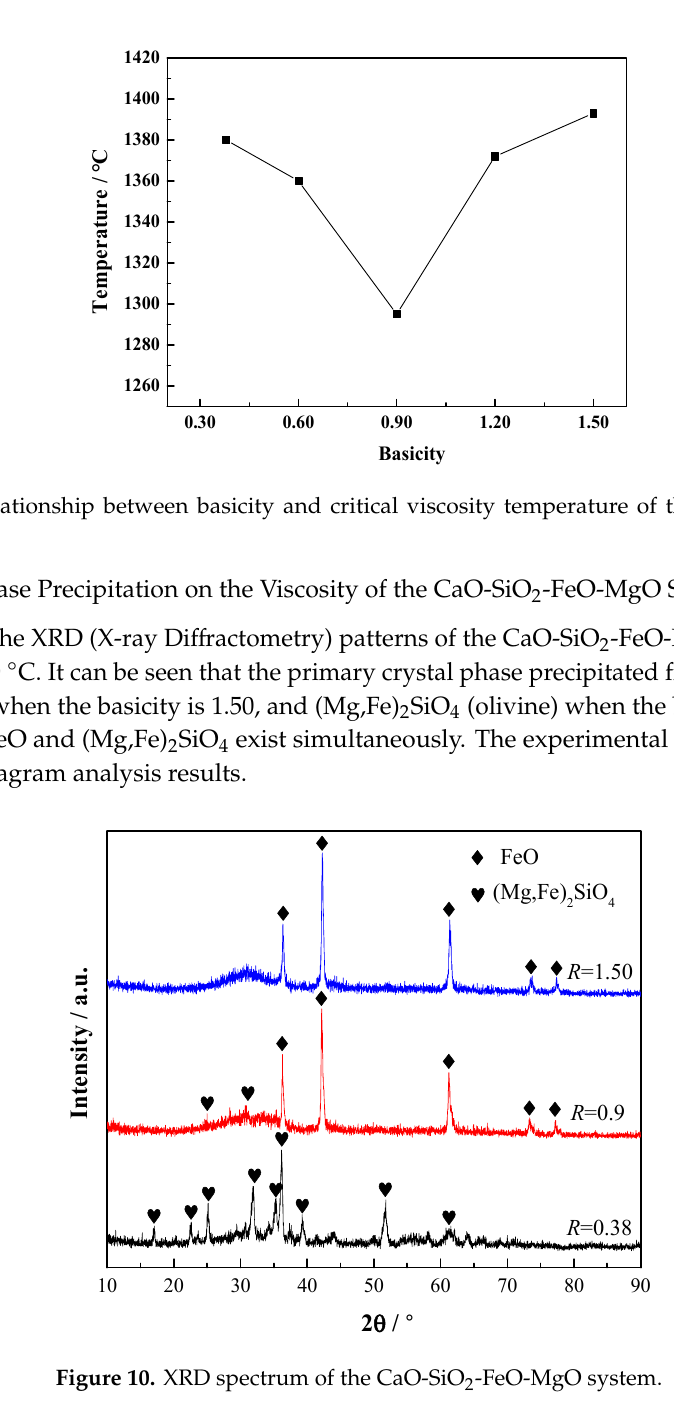
Figure 8. Example of the critical viscosity temperature for the CaO-SiO 2 - FeO-MgO system at the basicity of 0.38. Note the critical viscosity temperature is 1380 °C (1653 K).